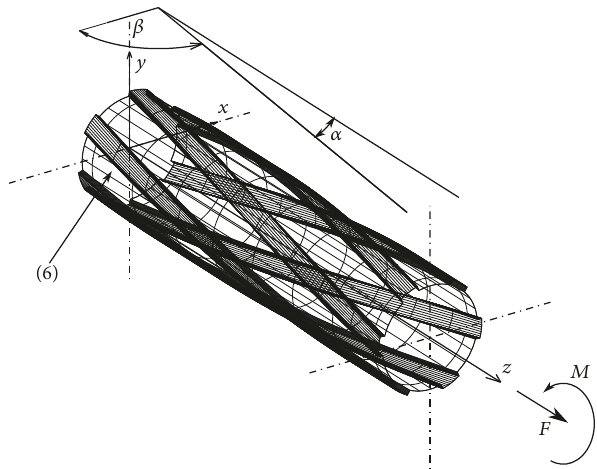
Figure 4: Helix angles and reference system of spline coupling.